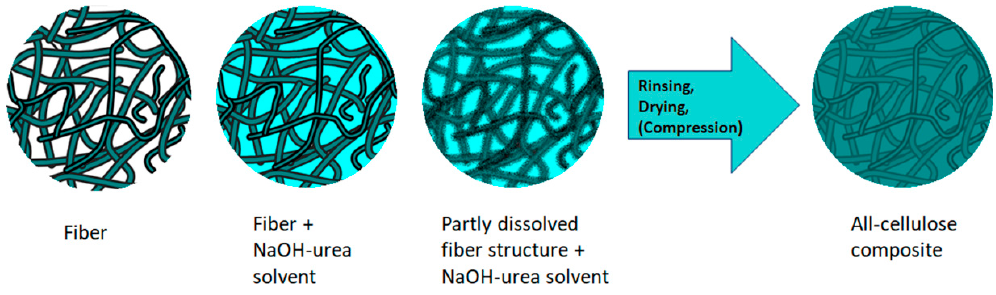
Figure 6. One-step method of creating all-cellulose composite with NaOH-urea solvent system.